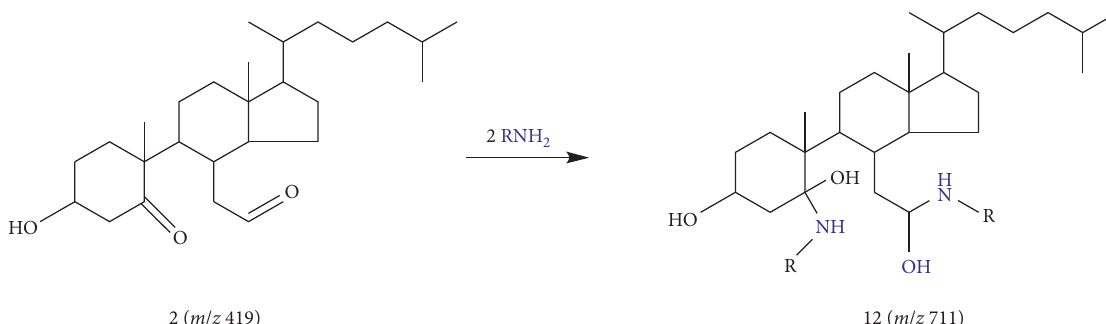
Scheme 4: Reaction of secosterol aldehyde 2 with two molecules of lysine (RNH